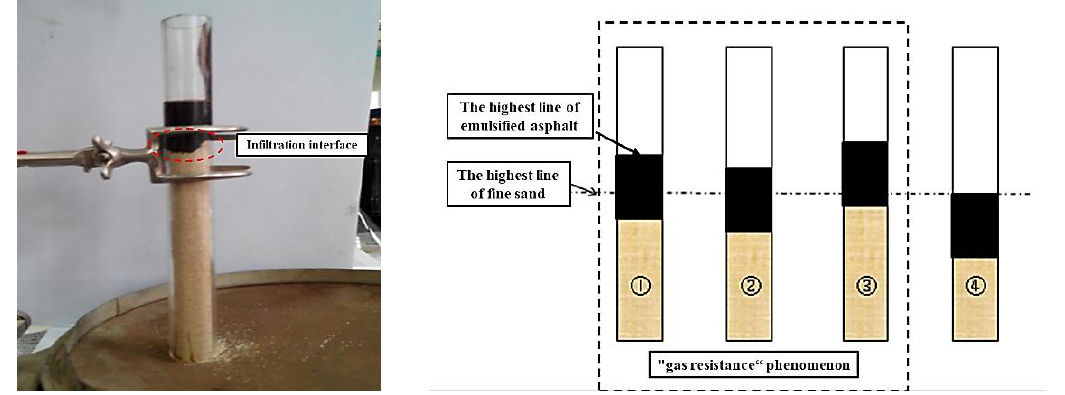
Figure 3. Problems in the existing penetration tests.